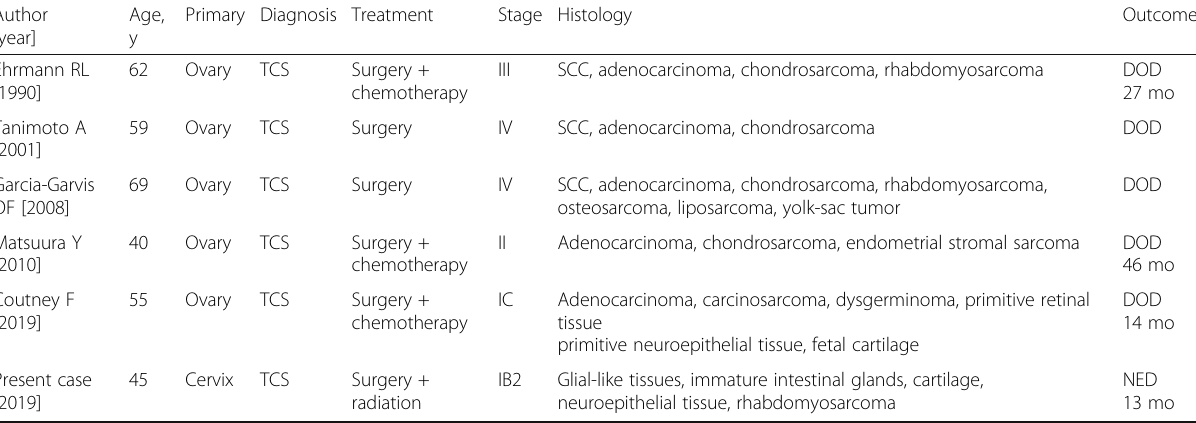
Table 2 Teratocarcinosarcomas of the female genital